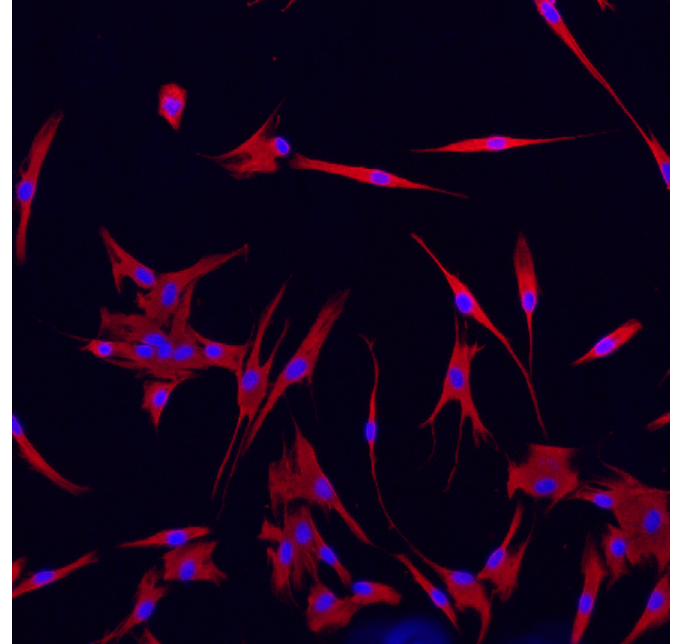
Figure 1- Characterization of human apical papilla cell (APC) culture by vimentin. Cultured APCs were immunostained for vimentin (red). Image captured by a fluorescence microscope at 40X